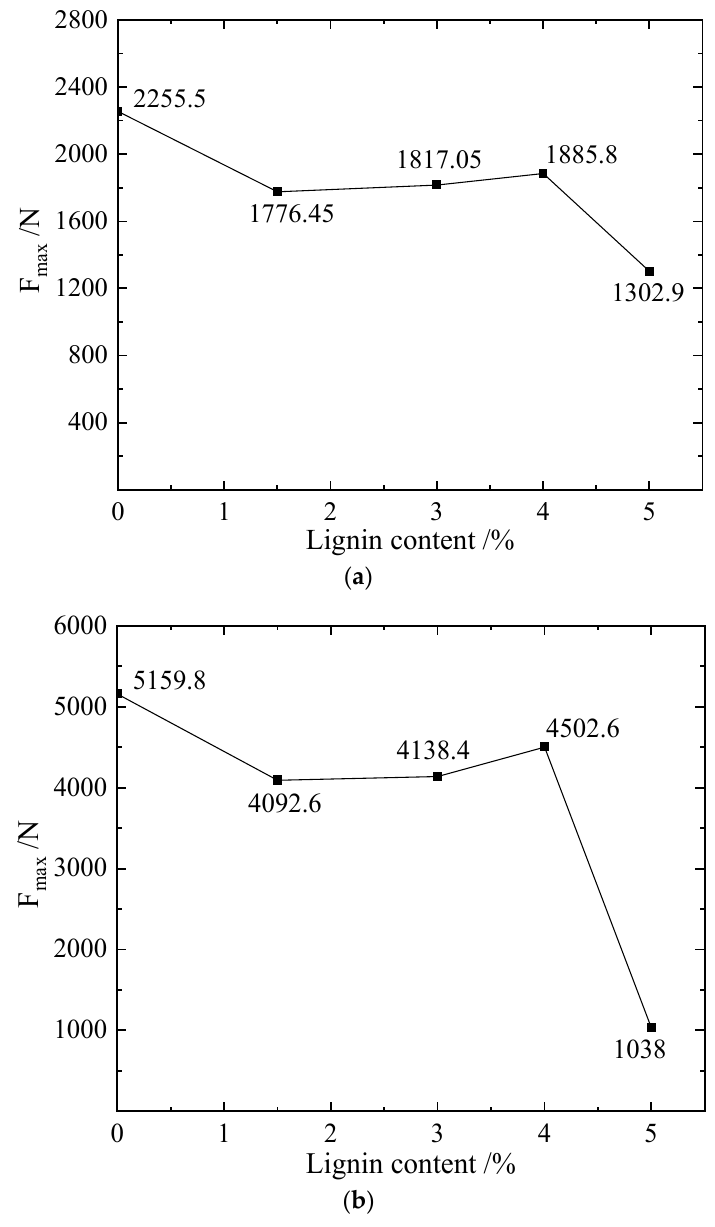
Figure 4. The ratio of lignin addition and the maximum axial force F max for different samples of E-L scheme. ( a ) Diagram of lignin addition ratio and maximum axial force F max of constant humidity sample. ( b ) Diagram of lignin addition ratio and maximum axial force F max of soaking sample in E-L scheme.